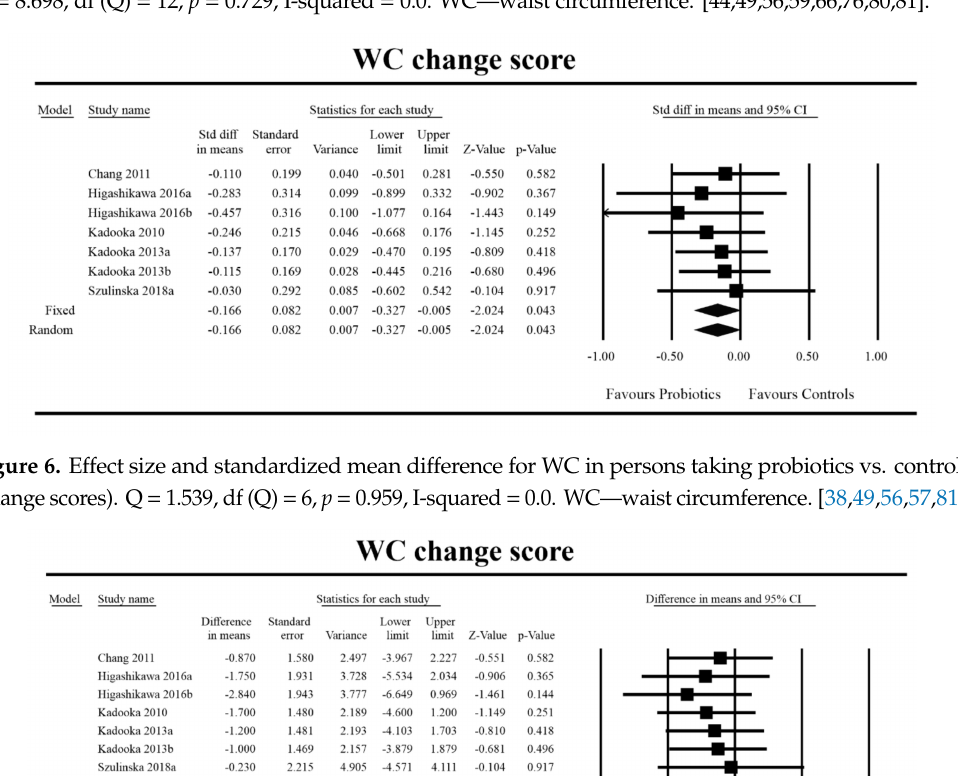
Figure 5. EffectsizeanddifferenceinmeansforWCinpersonstakingprobioticsvs. controls(endpointdata). Q = 8.698, df (Q) = 12, p = 0.729, I-squared = 0.0. WC—waist circumference. [44,49,56,59,66,76,80,81].